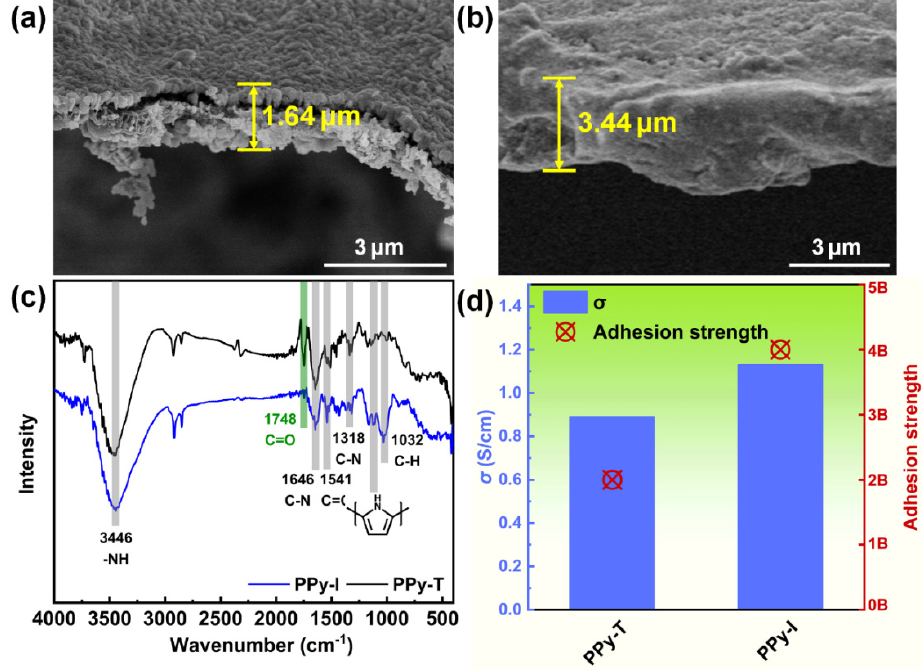
Figure 3. Cross-sectional morphologies of PPy-T ( a ) R a : 94 nm and PPy-I ( b ) R a : 93 nm coatings along with their FTIR spectra ( c ) and physical properties ( d ) in conductivity and adhesive grade.